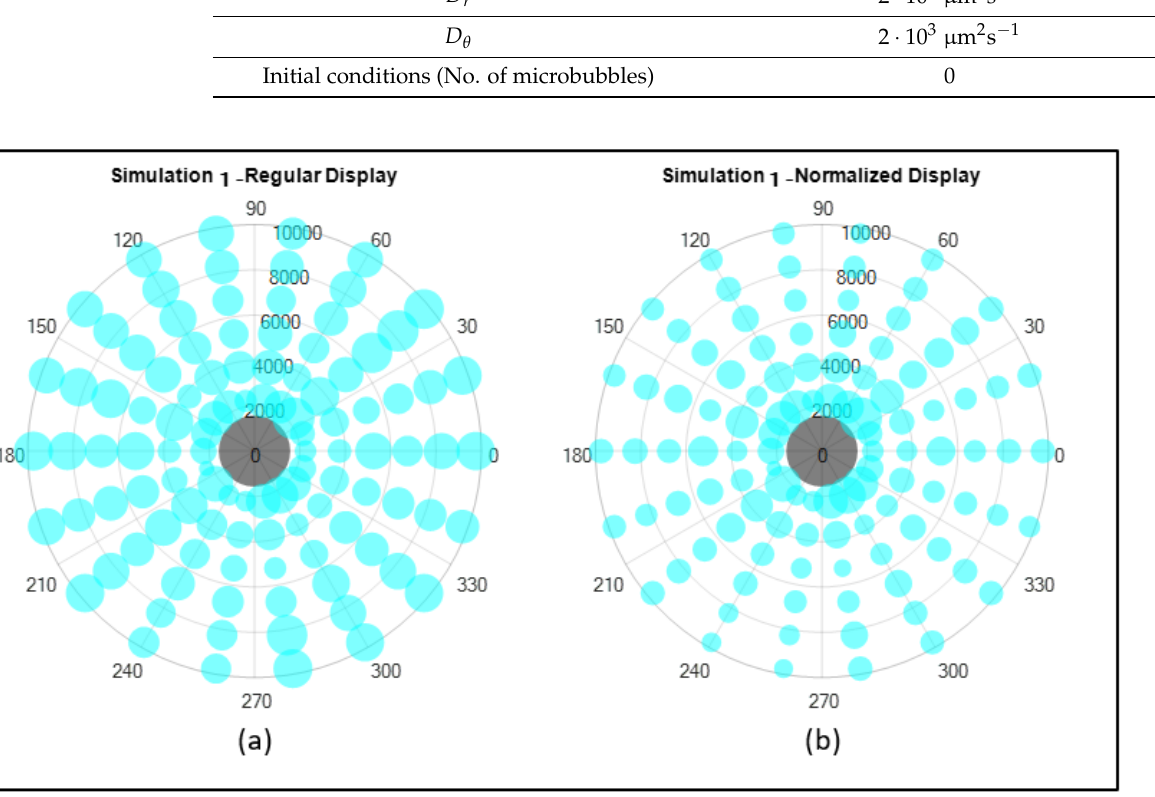
Figure 3. Simulation 1—Display of the general results of the relative number of microbubbles in each cell. ( a ) Regular display. ( b ) Number of microbubbles normalized to the cells’ volume.